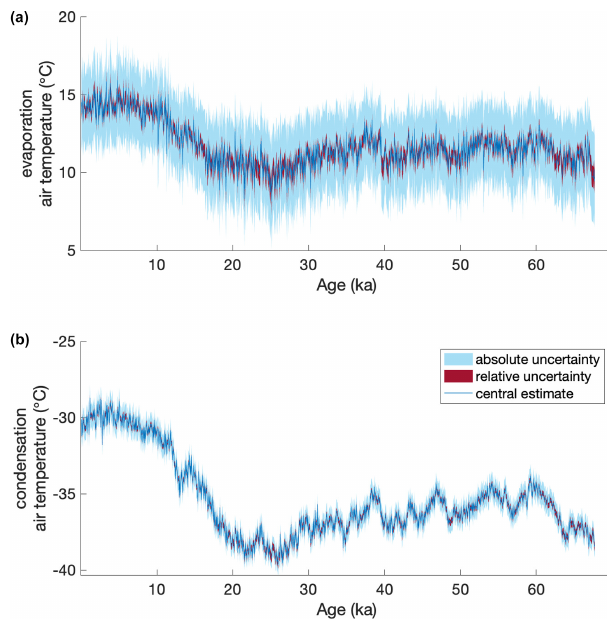
Figure 8. Temperature reconstructions and uncertainty estimates for the WAIS Divide ice-core (WDC) site. (a) moisture source mean evaporation temperature and (b) ice-core site condensation temper- ature. Dark blue lines are the central estimate, while red lines show the bounds of relative temperature uncertainty and cyan lines show the bounds of the absolute temperature uncertainty. Reconstructions resampled to even 40-year